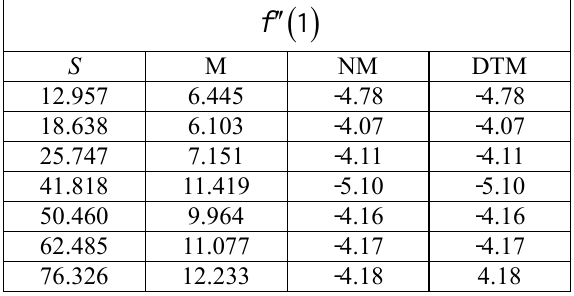
Results of NM and DTM of skin friction parameter for large separation number under the influence of magnetic field.